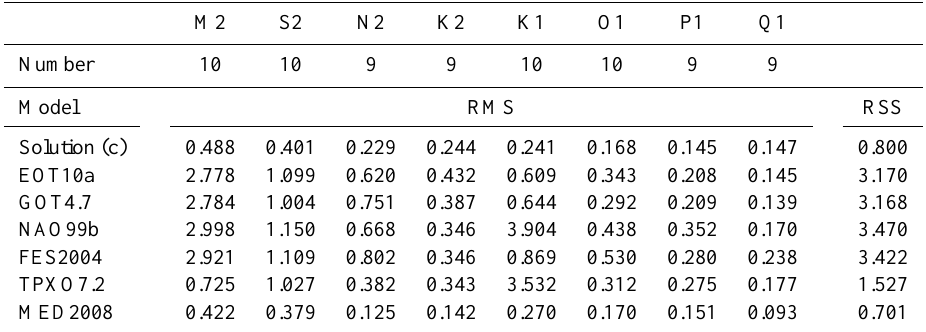
Table 9. RMS and RSS of the differences between the constituents of the control data set (i), the solution (c) of Table 7, and contemporary global and regional tide models. Unit